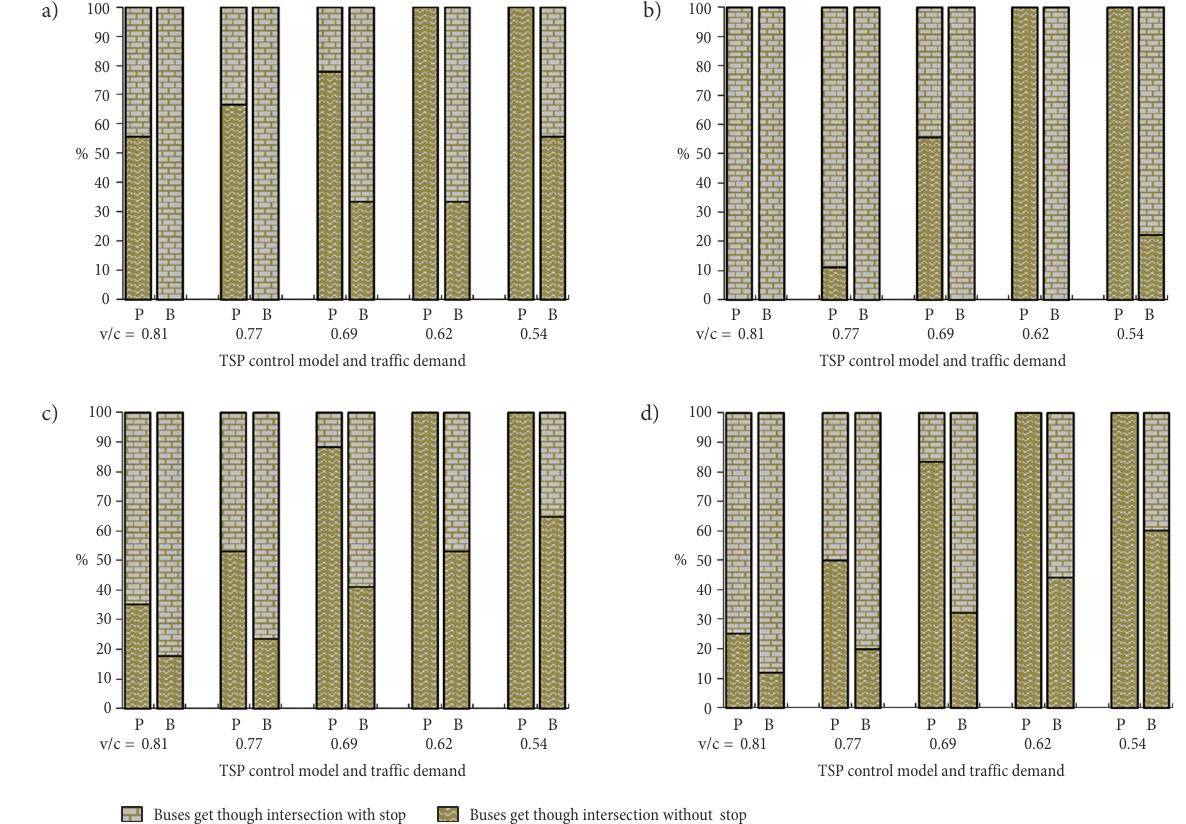
Buses get though intersection with stop Buses get though intersection without Fig. 4. Stop rate comparison ( note: P – Proposed TSP control model; B – Control b): a – headway = 622 s; b – headway = 502 s; c – headway = 382 s; d – headway = 262 s